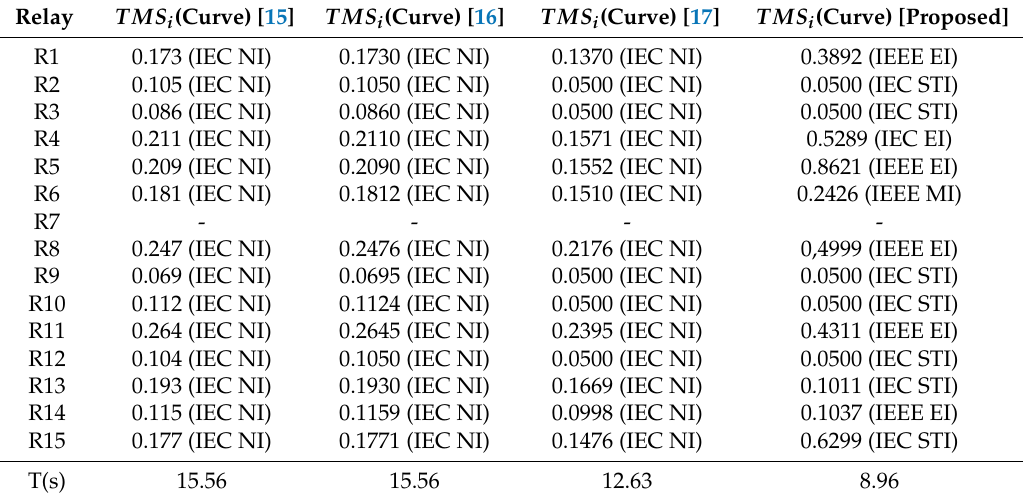
Table 10. Coordination parameters for OM4.